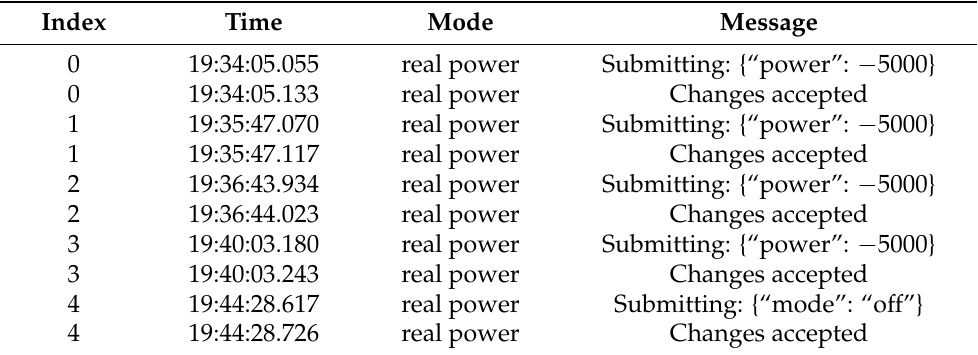
Figure 2. The real power outputs follow the Modbus commands even while being polled through the authenticated interface. Table 1. Event log captured via authenticated interface while Modbus commands were sent. Indices correspond with authenticated controller events labeled in Figure